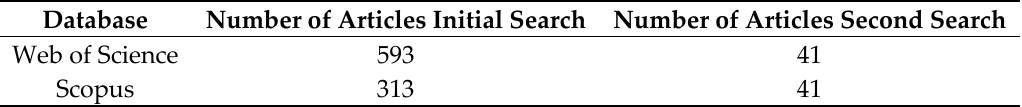
Table 1. Number of articles returned by each database and articles selected for further investigation